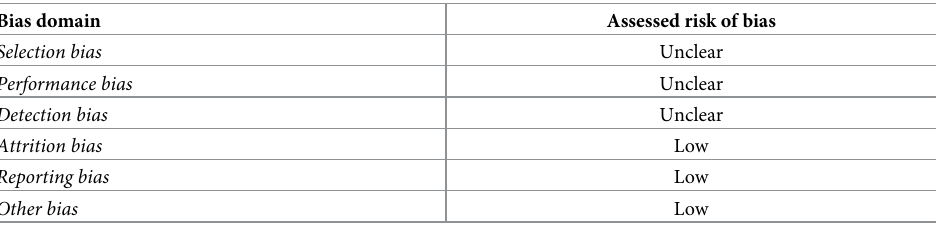
Table 2. Risk of bias